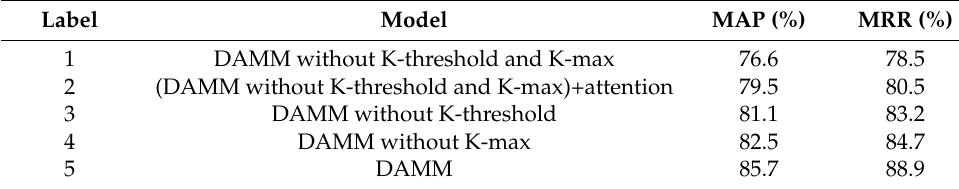
Table 7. Effect of different models on rice-related answer selection